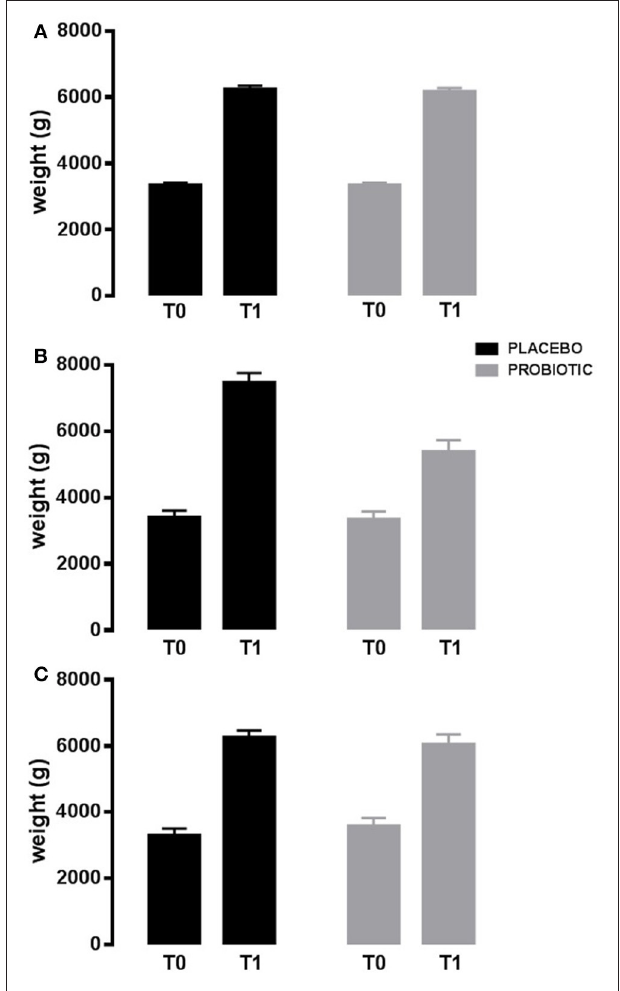
FIGURE 3 | Weight variation in 90 days. Probiotic group (gray bar) and placebo group (black bar). Newborns born by vaginal delivery (A) ; Newborns born by cesarean delivery (B) ; Newborns born by operative delivery (C) . Data are expressed as marginal mean ± SEM. Data are significant in interaction ( p < 0.03; model 2). T0: baseline. T1: after 90 days of